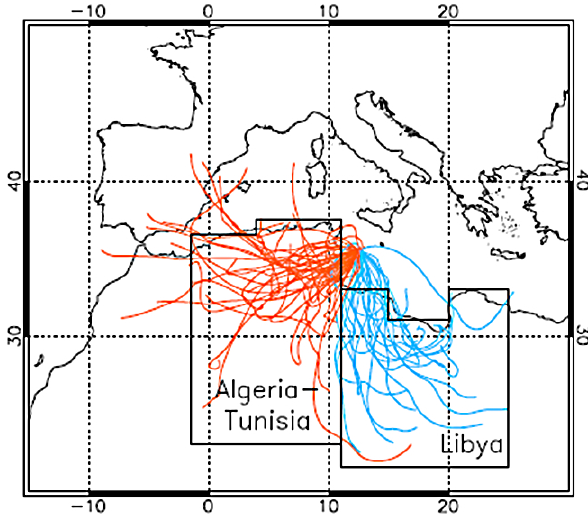
Fig. 7. Dust source regions and back trajectories fulfilling the 50% permanence criterion for each source region (orange for Algeria– Tunisia and blue for Libya).